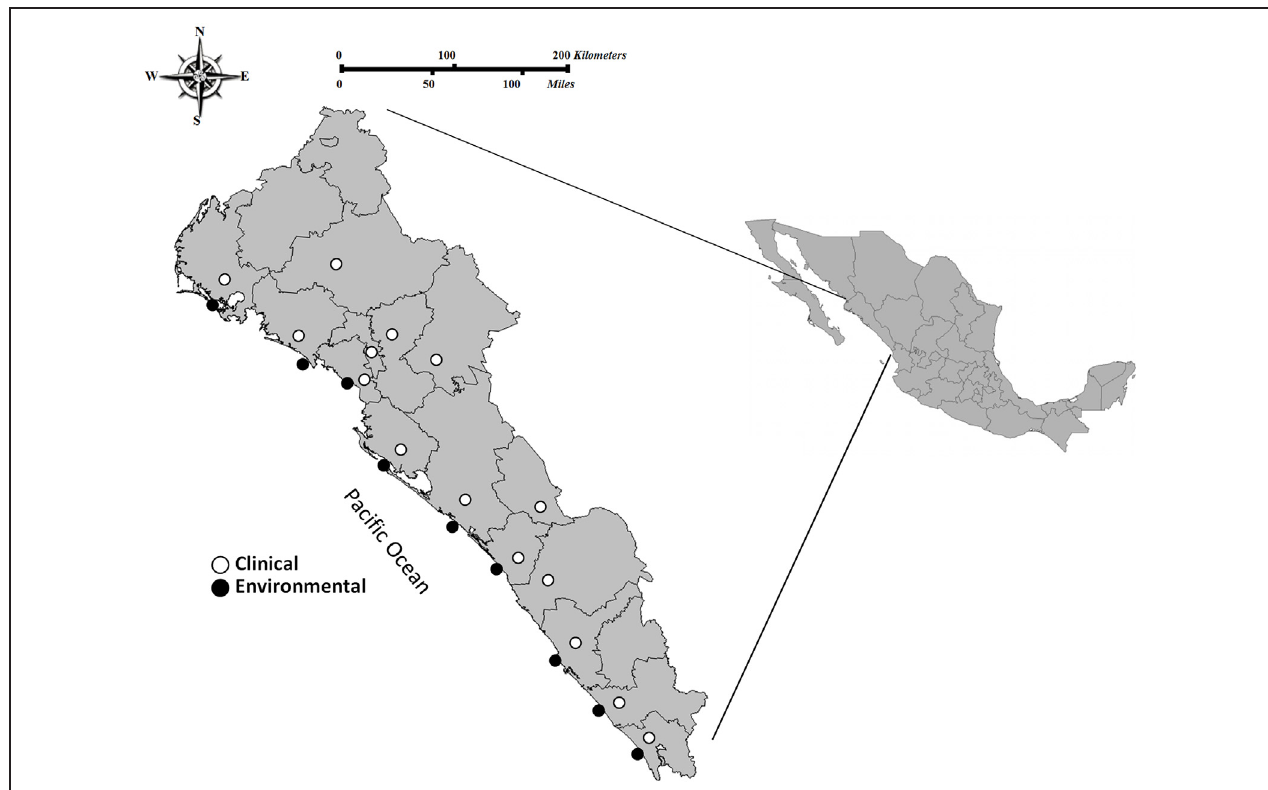
FIGURE 1 | Area of study and locations of the sampling sites in the Pacific Northwest coast of Mexico. Clinical cases (stools specimens or rectal swabs; n = 10,521 of which 249 were positive isolates for Vibrio